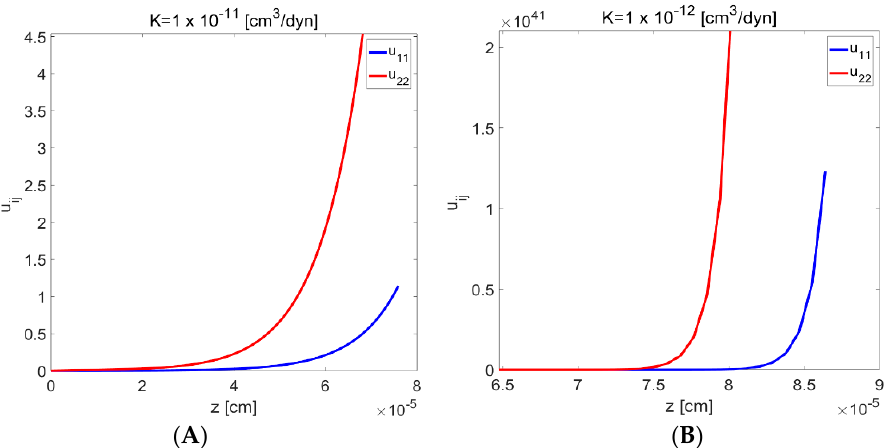
Figure 8. Jacobi’s functions u 11 ( z ) and u 22 ( z ) plotted against the length of the transition region z ( cm ), for two different values of the elasticity coefficient, K , ( A ) K = 1 × 10 − 11 and ( B ) K = 1 × 10 − 12 . Reproduced with permission from [19]. Copyright © 2018 American Chemical